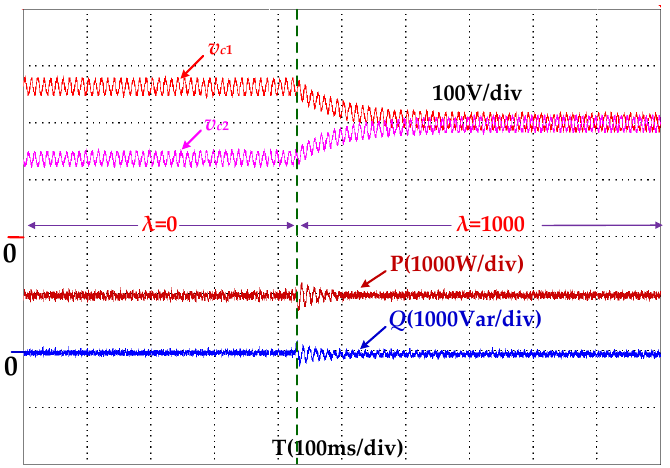
Figure 14. Dynamic experimental results of transition between inverter and rectifier mode with the proposed CF-MPDPC.